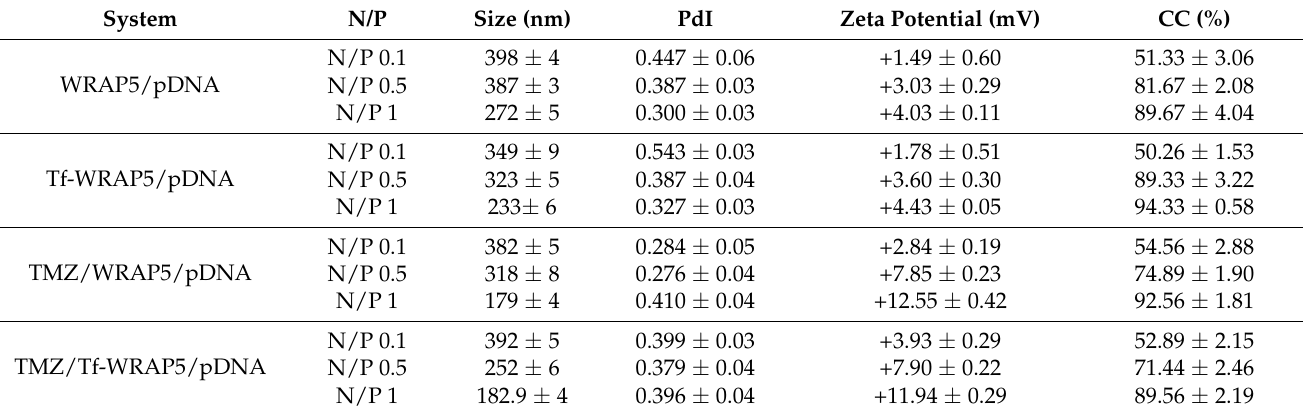
Table 2. Mean size, polydispersity index, average zeta potential, and pDNA complexation capacity (CC) for WRAP5/pDNA, Tf-WRAP5/pDNA, TMZ/WRAP5/pDNA, and TMZ/Tf-WRAP5/pDNA complexes formulated at different N/P ratios (0.1, 0.5, and 1). The values were calculated with the data obtained from three independent measurements (mean ± SD, n =